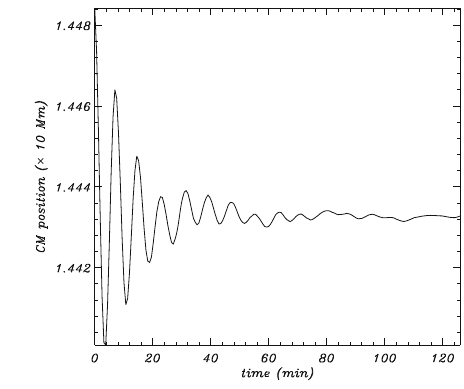
Fig. 70 Temporal evolution of the centre of mass position in a numerical solution for vertical oscillations of a prominence embedded in a magnetic flux rope with a low prominence–corona density contrast in the weak twist regime ( N t = 2 . 2 in the Titov and Démoulin 1999 model), and a spatial resolution of 600 km. Image reproduced with permission from Terradas et al. (2016), copyright by